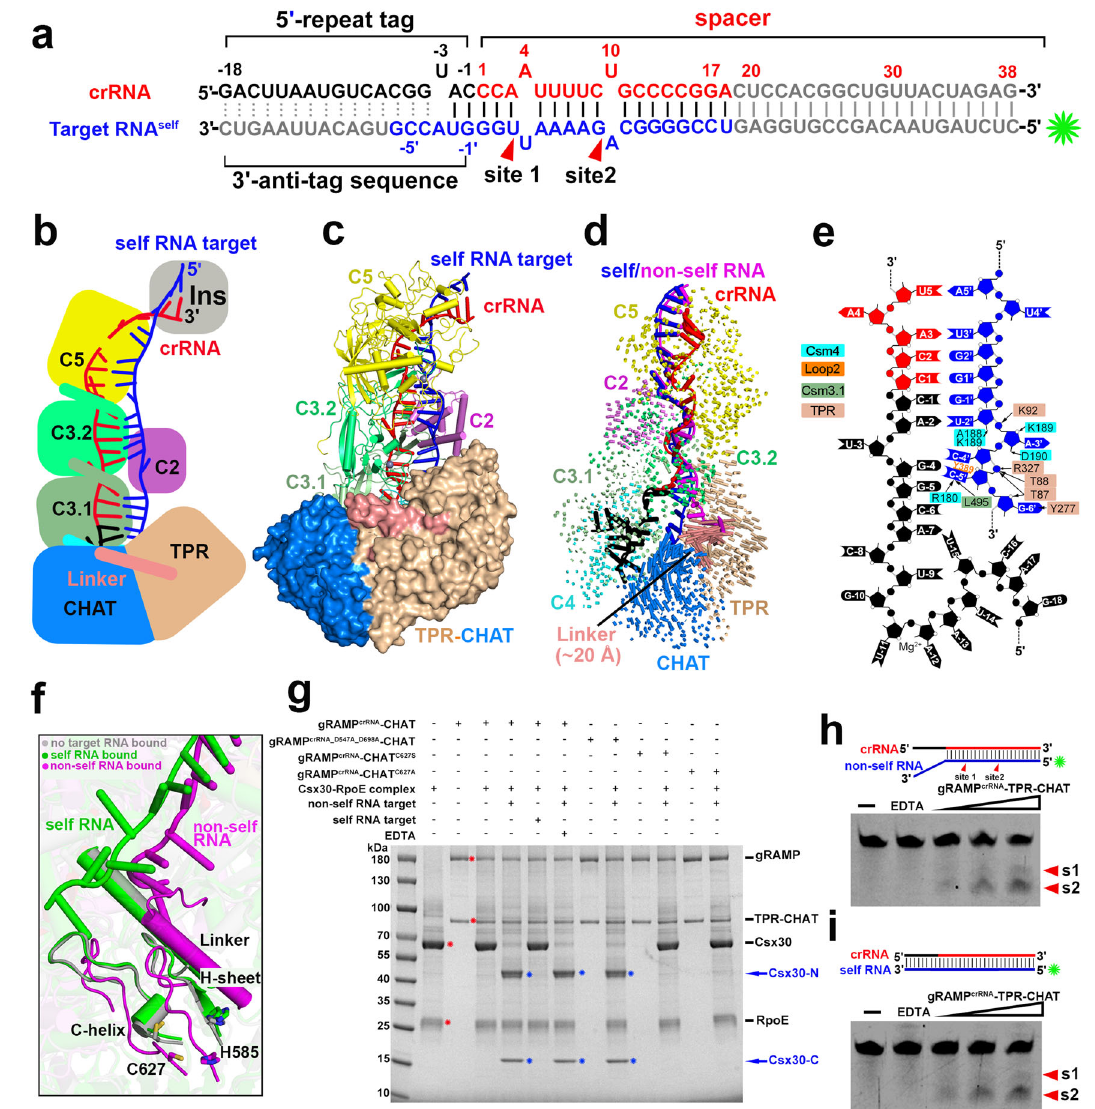
Fig. 5 | Cryo-EM structure of gRAMP crRNA -TPR-CHAT bound to self RNA target. a Schematic representation for the sequences of crRNA and self RNA target. The traced and disordered segments are in color and gray, respectively. Schematic ( b ) and cartoon ( c ) representations of cryo-EM structure of self RNA target bound to gRAMP crRNA -TPR-CHAT quaternary complex. TPR-CHAT protein is shown in a sur- face view. d Structural comparison between gRAMP crRNA -TPR-CHAT complex bound to self and non-self RNA targets. Vector length correlates with the domain movement scale. e Schematic interactions between the 3 ′ - fl anking sequence and proteinresidues.Hydrogenbondsandstackinginteractionsareindicatedbyblack arrows and orangelines, respectively. f Conformational changes of the Linker and CHAT protease catalytic pocket in TPR-CHAT induced by self (in green) and non-